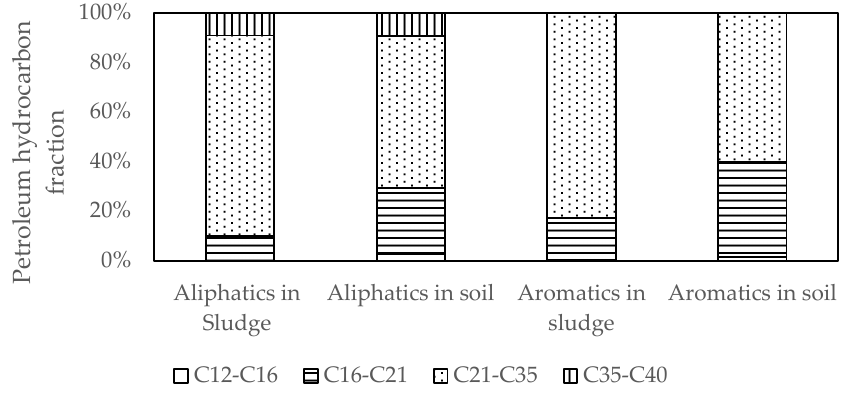
Figure 7. Petroleum hydrocarbon composition of the sludge and the underlying soil.